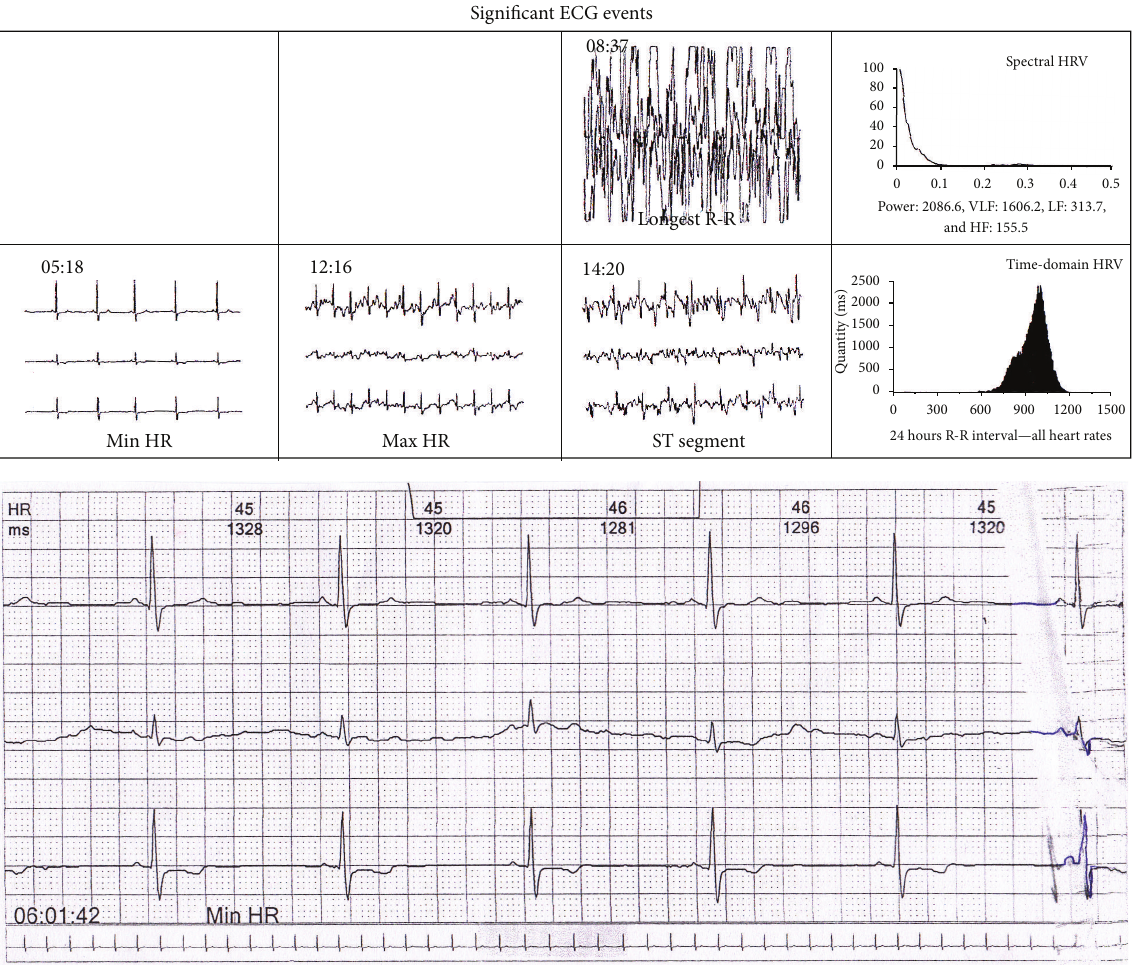
Figure 2: Some significant ECG events and minimal heart rate ECG record which were detected at 24-hour rythm holter ECG.